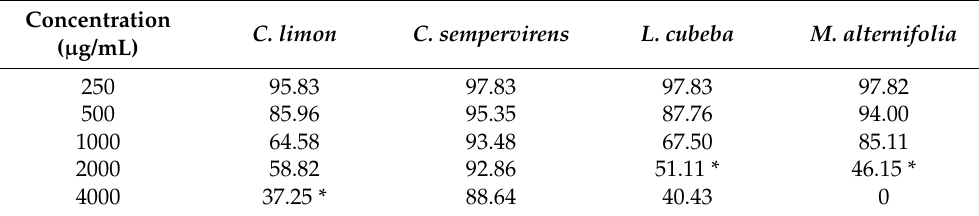
* LC 50 : lethal concentration responsible for the mortality of 50% of C. elegans larvae.